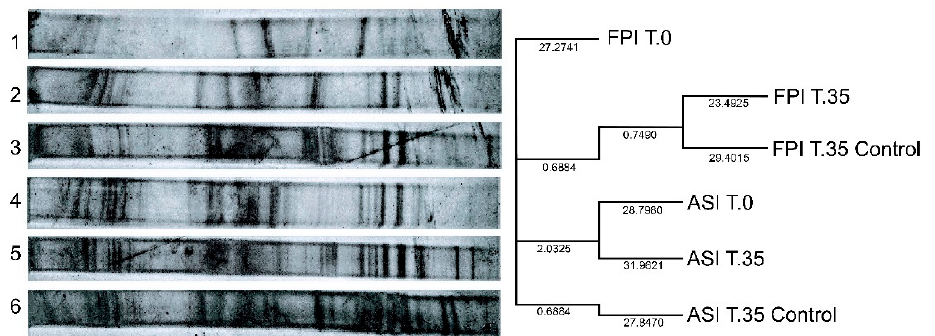
Figure 4. Pearson–Phi correlation coefficient distance cladograms generated from the DGGE fin- gerprints profile of nif H gen of ( 1 ) FPI Phase 2-Initial time (T.0); ( 2 ) FPI Phase 2-end (T.35); ( 3 ) FPI Control-end (T.35); ( 4 ) ASI Phase 2-Initial time (T.0); ( 5 ) ASI Phase 2-end (T.35); ( 6 ) ASI Control-end (T.35). Detected by silver-nitrate staining.